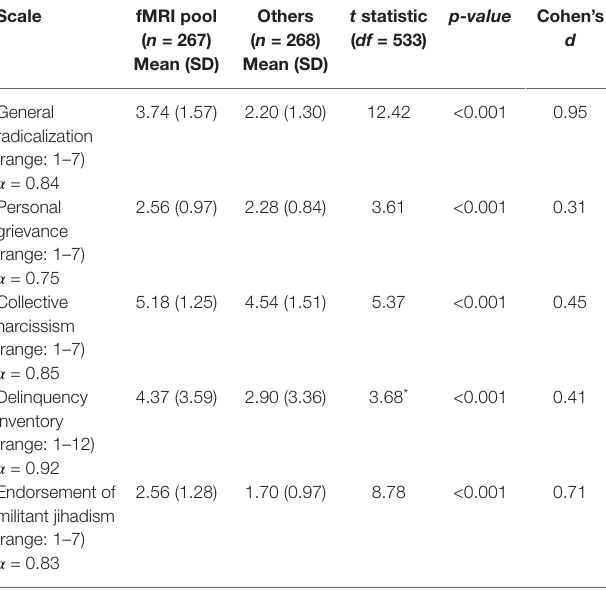
TABLE 1 | Behavioral comparison between the sample selected for the fMRI session (“fMRI pool”) and the rest of the field survey respondents (“Others”).